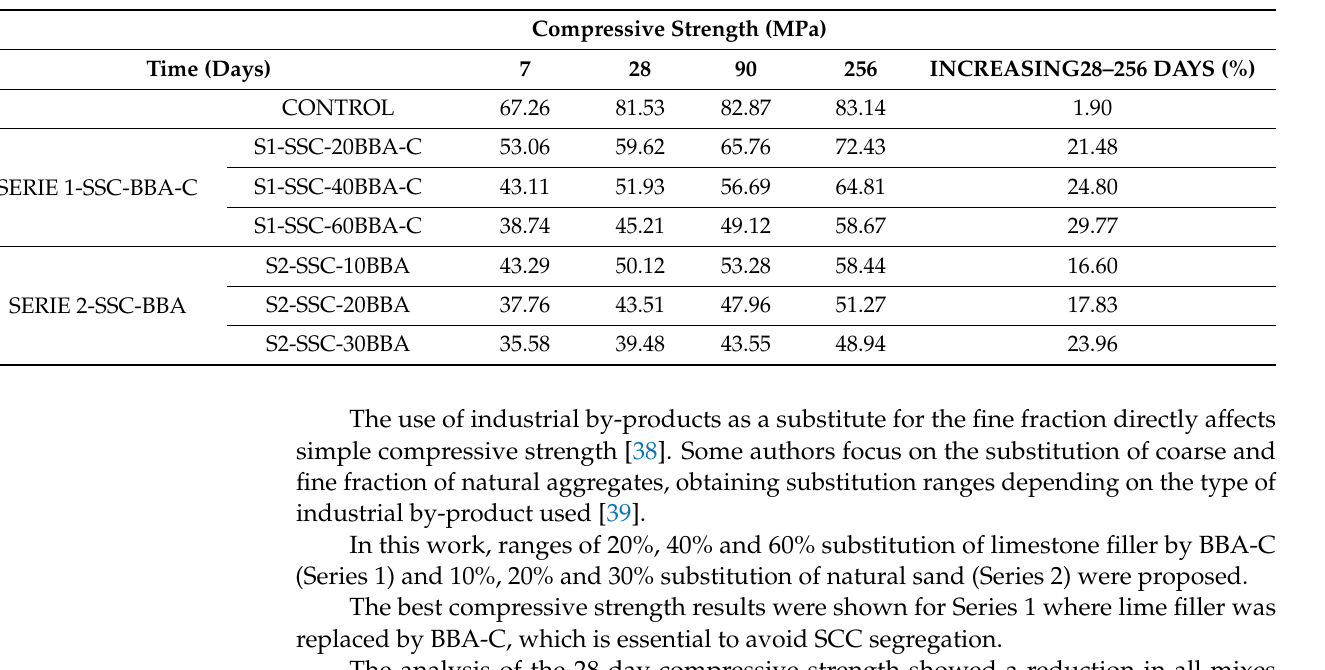
Table 5. Compressive strength of